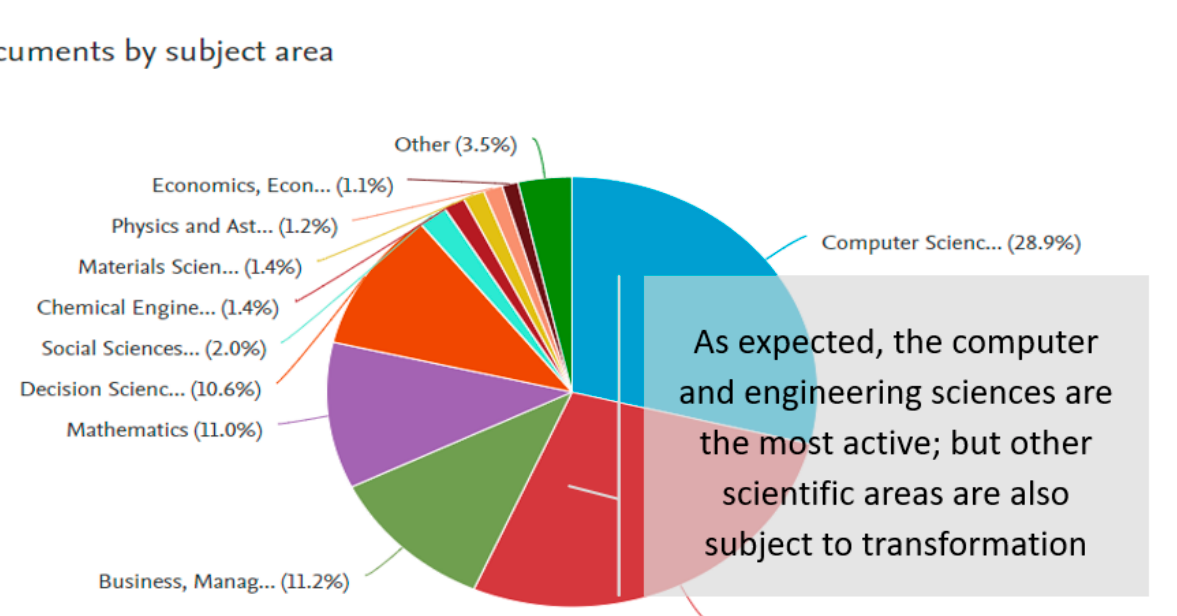
Figure 3. Agile AND transformation AND manufacturing—Documents by Type.